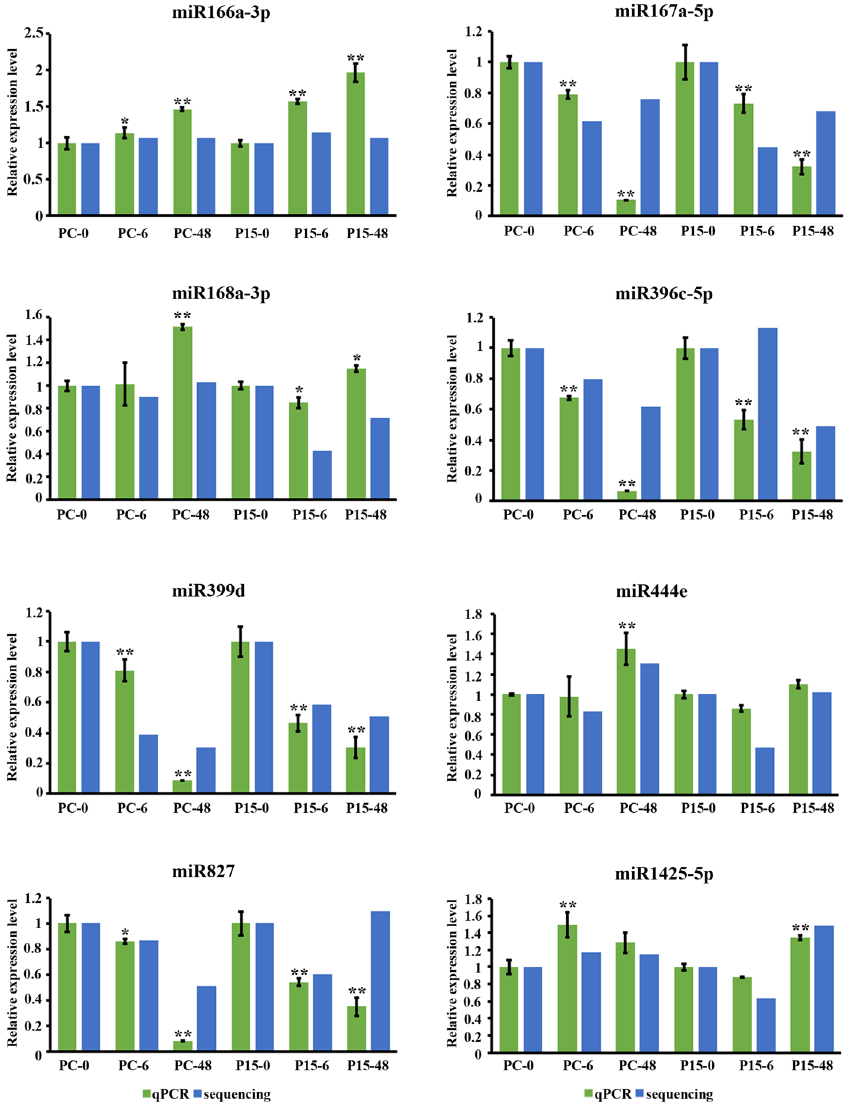
Figure 3. Stem-loop RT-PCR analysis of known miRNA levels in P15 and PC compared to sequencing results. The expression of miRNAs was normalized by small RNA U6. The data represent the mean ± SD from three biologically independent experiments. Statistical significance was analyzed using one-way ANOVA. The asterisks represent significance, where one asterisk indicates P ≤ 0.05, and two asterisks indicates P ≤